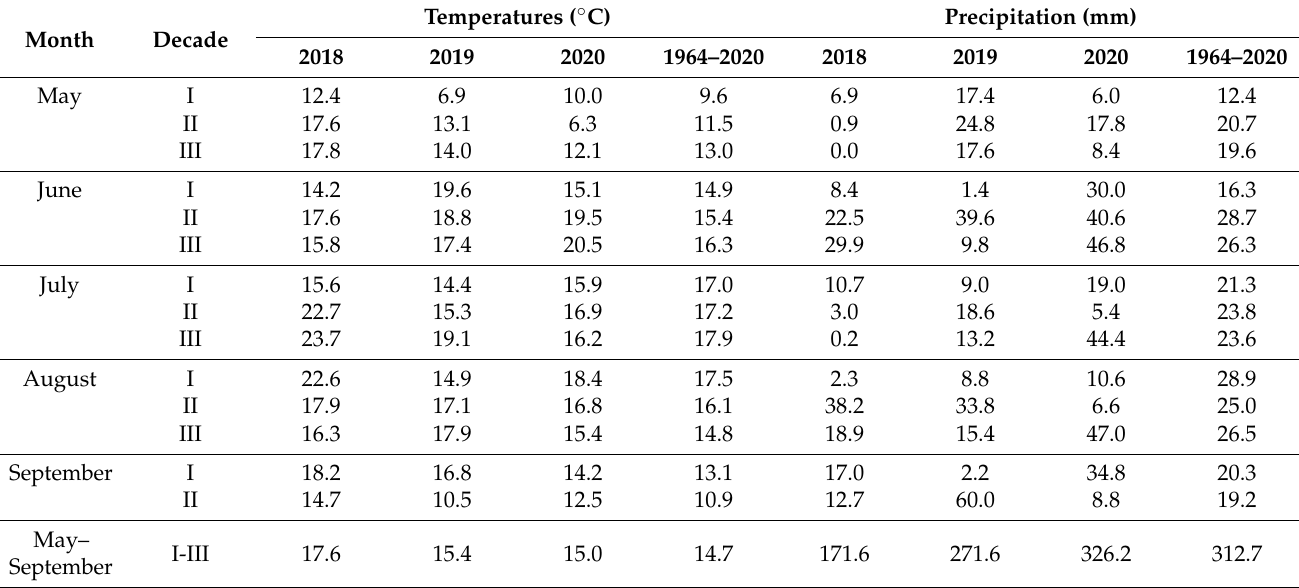
Table 1. Weather conditions during 2018–2020 * and the long-term average (1964–2020). Temperatures ( ◦